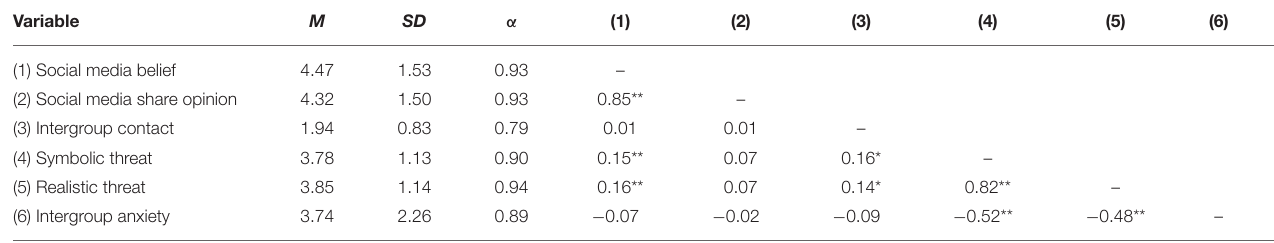
TABLE 2 | Means, standard deviation, reliability coefficients, and correlations.